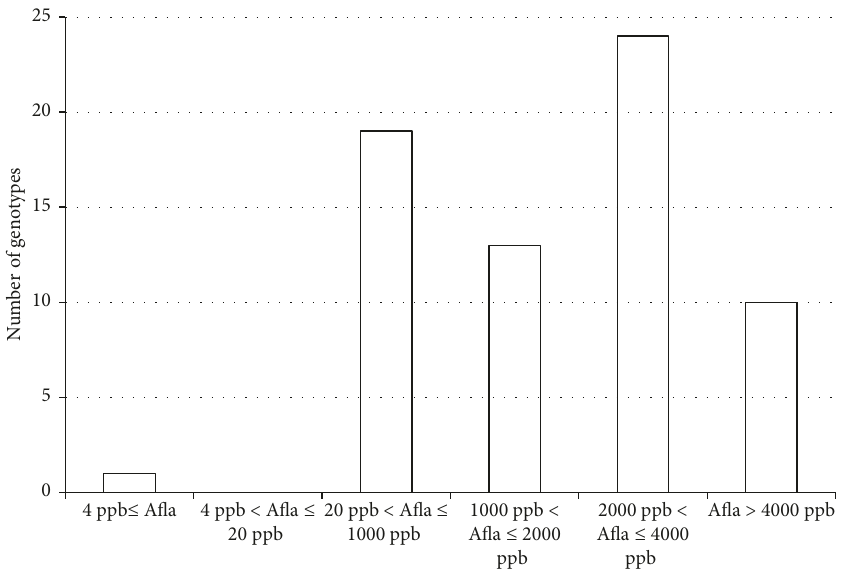
Figure 1: Number of peanut genotypes according to aflatoxin concentration level interval values.